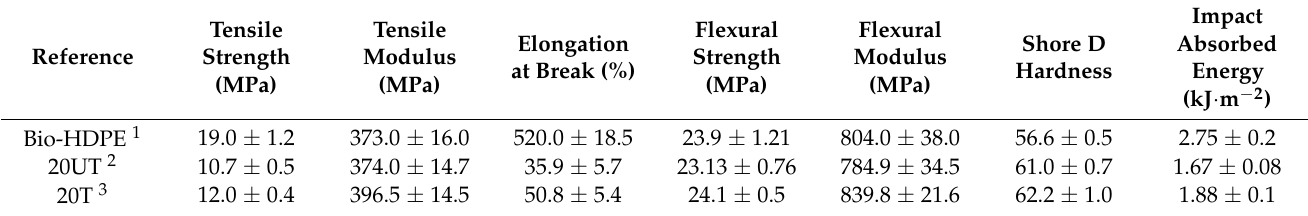
Table 2. Mechanical properties for Bio-HDPE with untreated and treated chia seed